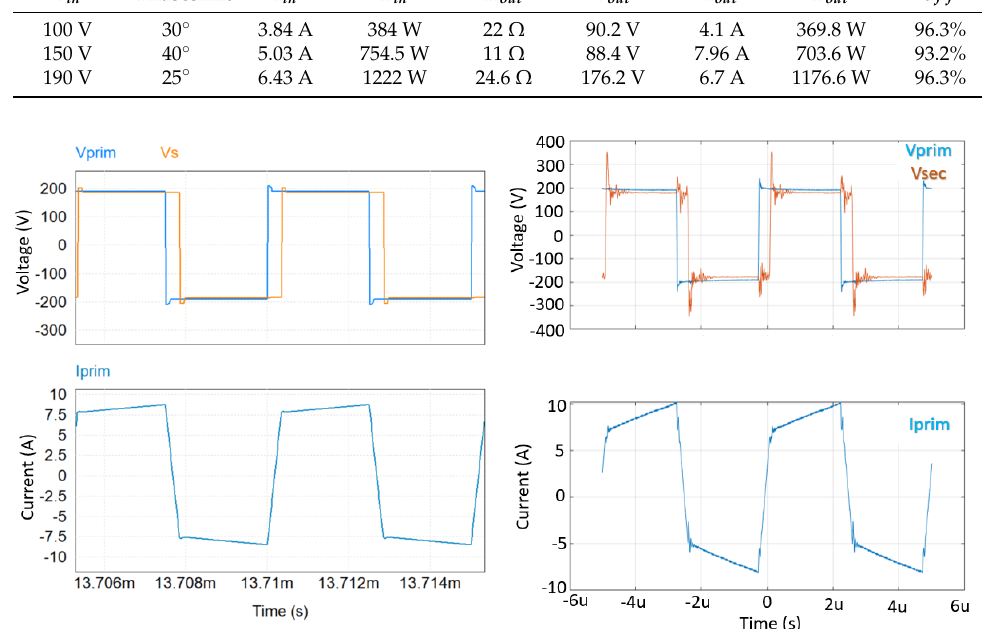
Figure 18. Comparison between simulation ( left ) and measured ( right ) values of primary/secondary voltages and primary current in the V in = 190 V and R out = 24.6 Ω